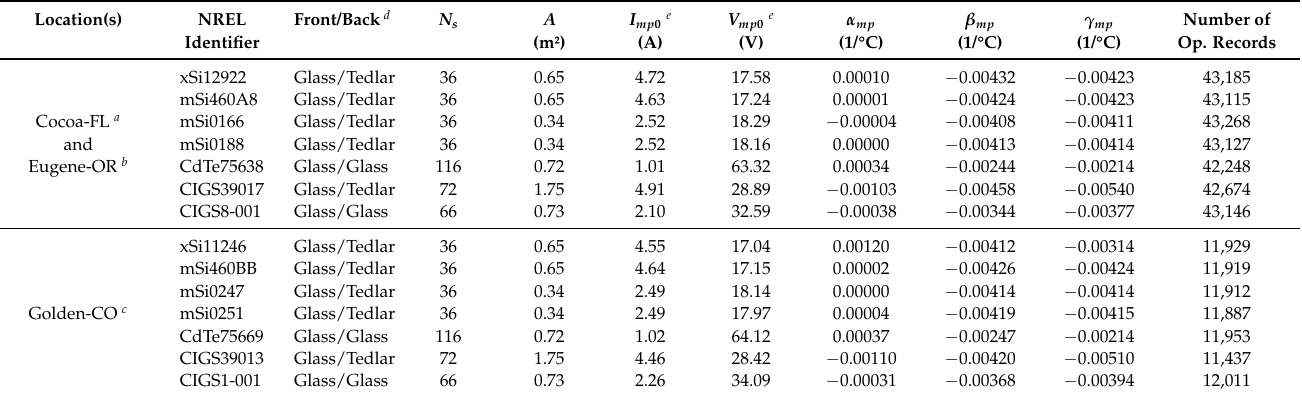
Table 2. Characteristics of the PV modules adopted as the object of study